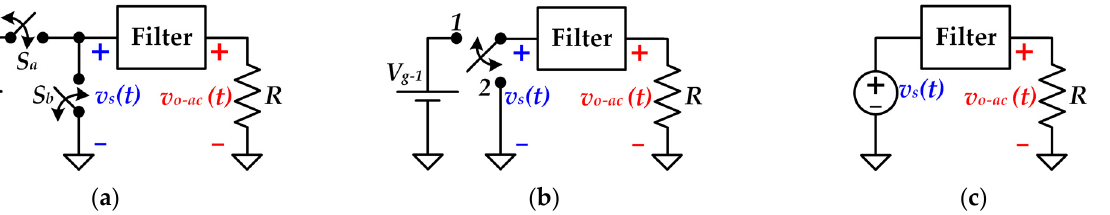
Figure 3. Equivalent circuits of a Class D SMPA: ( a ) Considering two complementary controlled switches. ( b ) Considering a single-pole double-throw switch. ( c ) Considering a pulse-voltage source at the input of the filter.